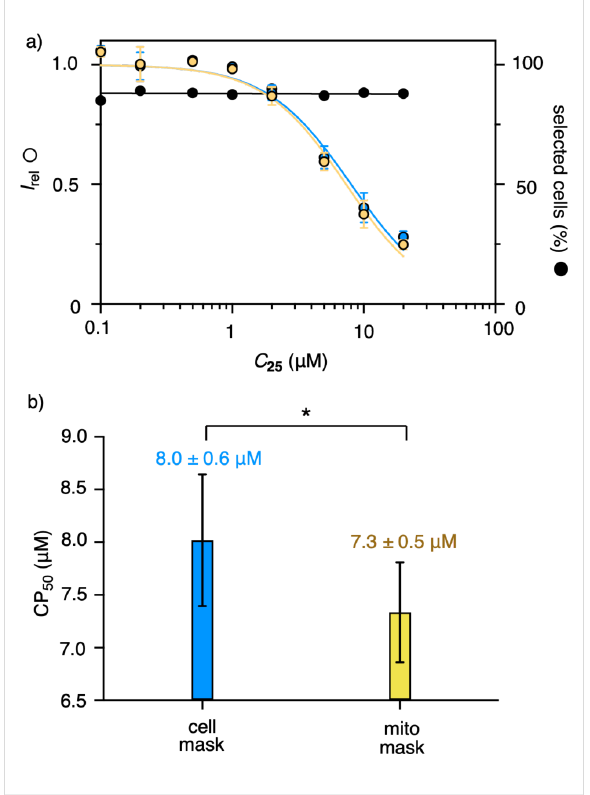
Figure 9: a) Automated HC imaging of the cellular uptake of 25 , covering the concentration dependence for the HC CAPA with the cell body mask (blue), the HC CAPA with the mitochondrial mask (yellow), and the toxicity defined as the percentage of damage-free cells selected for the HC CAPA (black), all recorded in one automated ex- periment. (b) The CP 50 value of 25 with standard errors using the cell body mask (blue) and the mitochondrial mask (yellow). The statistical significance was determined using the one-tailed paired Student’s t-test: * p <